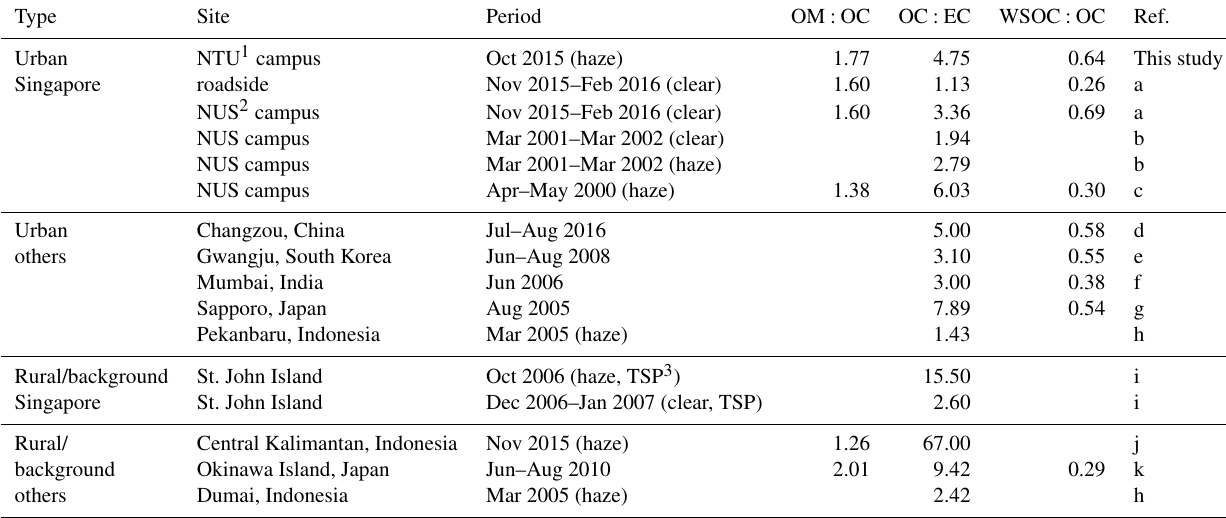
Figure 2. Average diurnal profiles of NR-PM 1 chemical species during the 2015 haze episode in Singapore. Vertical bars show one standard deviation. Table 2. Ratios of OM : OC, OC : EC, and WSOC : OC of the atmospheric aerosols from urban and rural or background in Singapore and other Asian